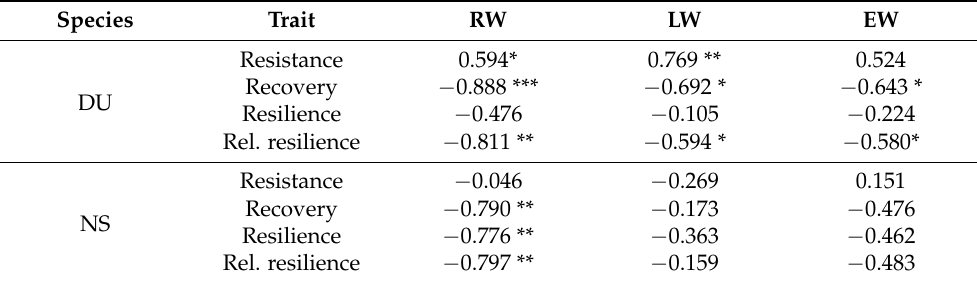
Figure 7. The ranking of drought parameters for Douglas fir (DU) and Norway spruce (NS) in forest genetic resources (FGR 1 and FGR 2). Table 6. Phenotypic correlations between wood characters and drought parameters of Douglas fir (DU) and Norway spruce